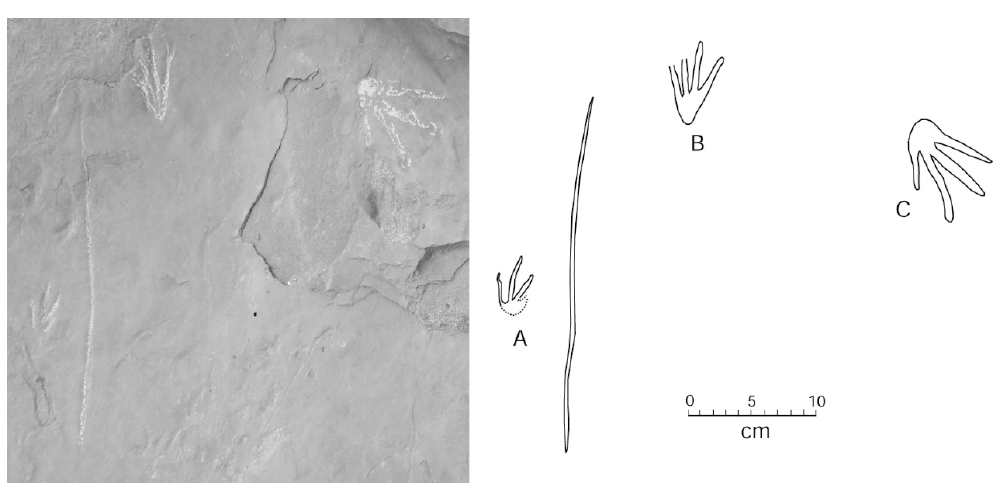
Figure 11. Trackways showing multiple footprints and tail drag marks. Specimen WWU-TR-073. A . left manus; B . right pes. Both footprints are in proximity to a central tail drag mark. C . right manus from a larger Crocodylian traveling in a different direction. Footprints are highlighted with chalk.